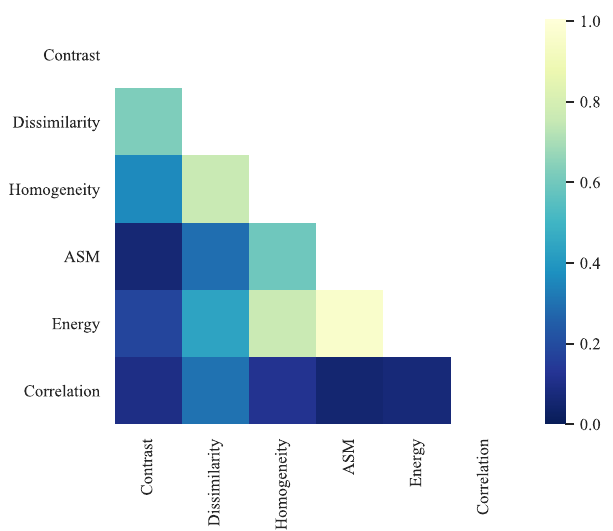
Figure 7. Correlation matrix heat map of texture